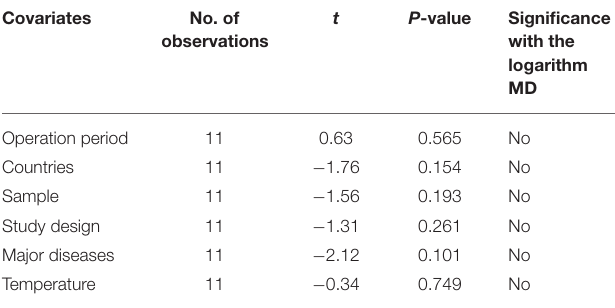
TABLE 4 | Metaregression analyses.